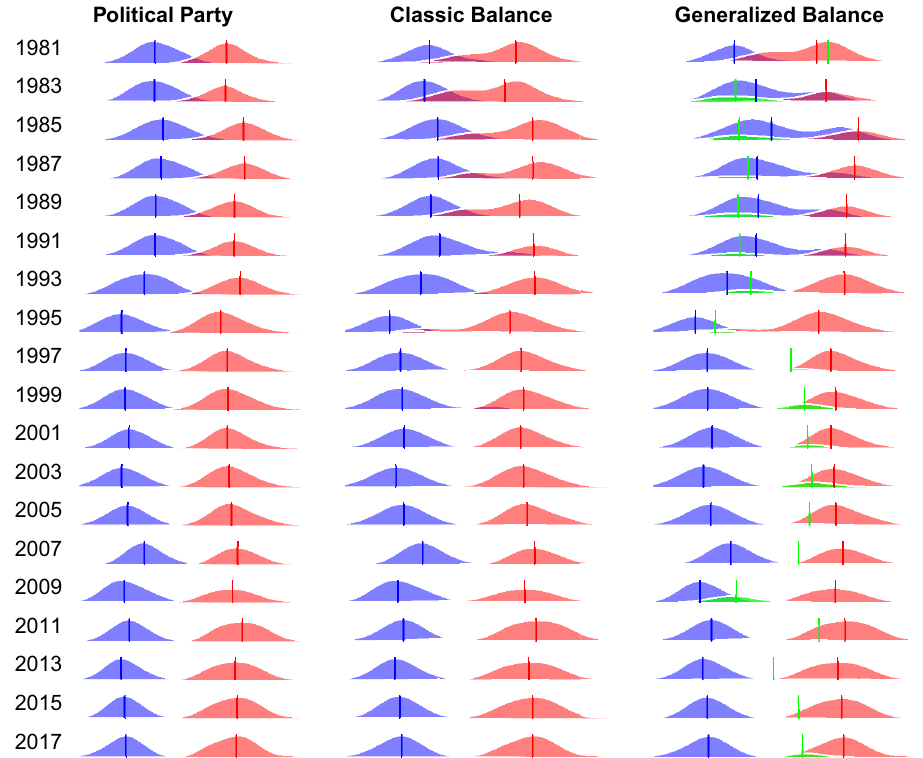
Figure 3. Distribution of coalition members’ ideology in the US House of Representatives. Blue (red) curves indicate the ideologies of Democrats (Republicans) in the left column and that of the dominant liberal (conservative) coalitions in the center and right columns. In the right column, green curves indicate the ideologies of members of the smallest